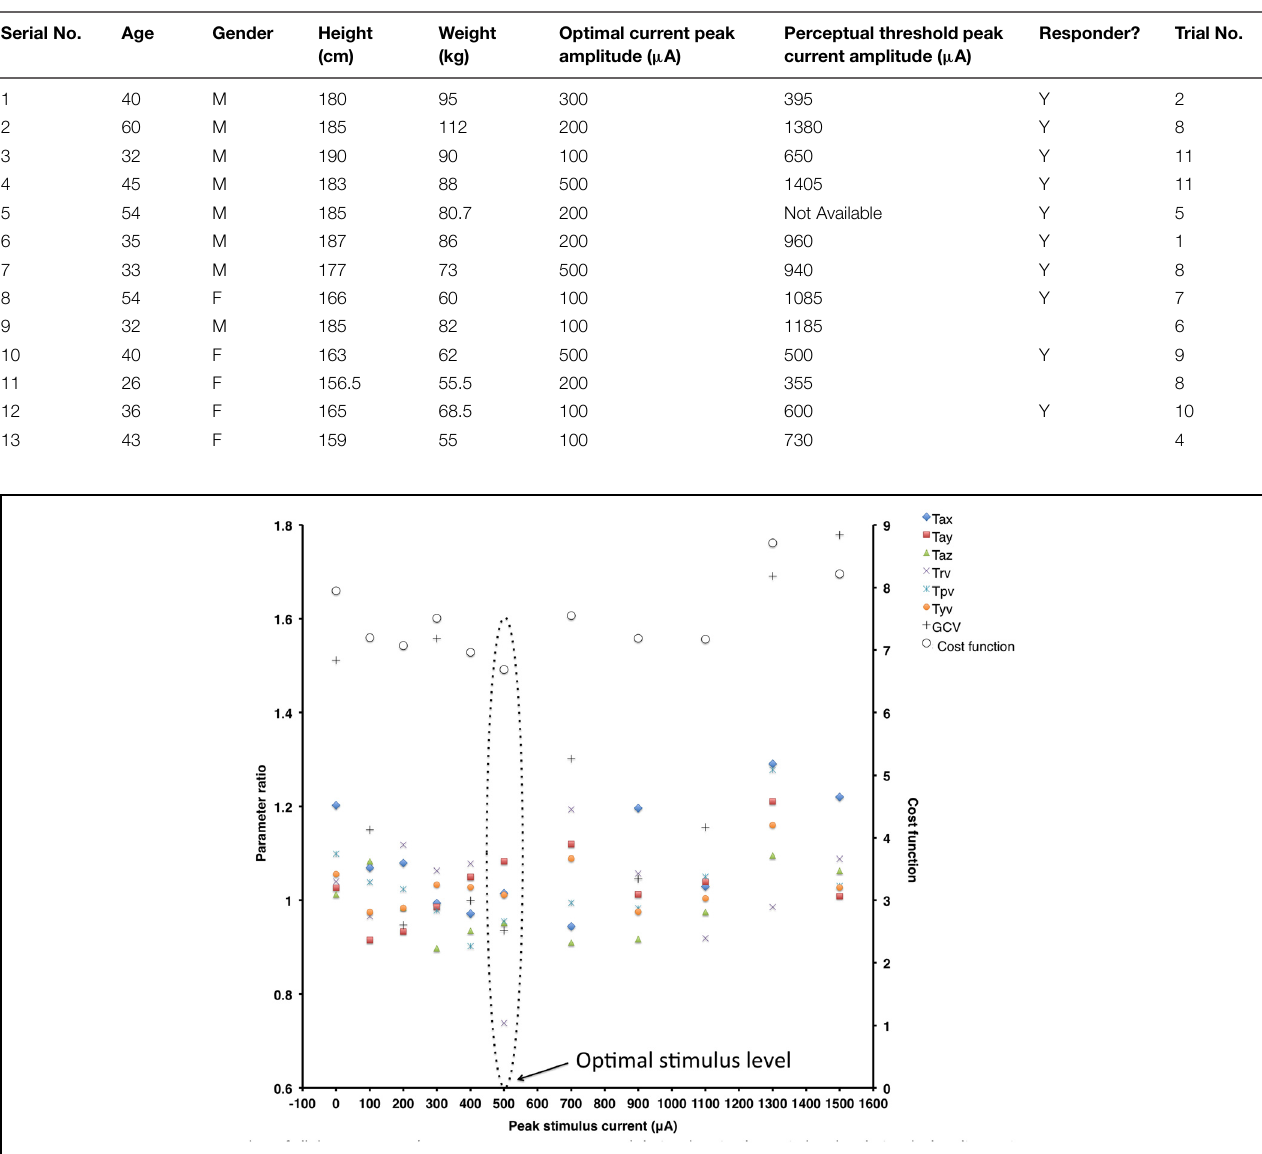
TABLE 1 | Subjects’ demographics, optimal value of the peak current amplitudes for the stochastic vestibular stimulation (SVS) for optimal trials, the threshold amplitude of perceptual motion, whether the subject was responsive during their optimal trials with respect to the control trials and the trial number at which optimal performance was exhibited out of a maximum of 11 trials.